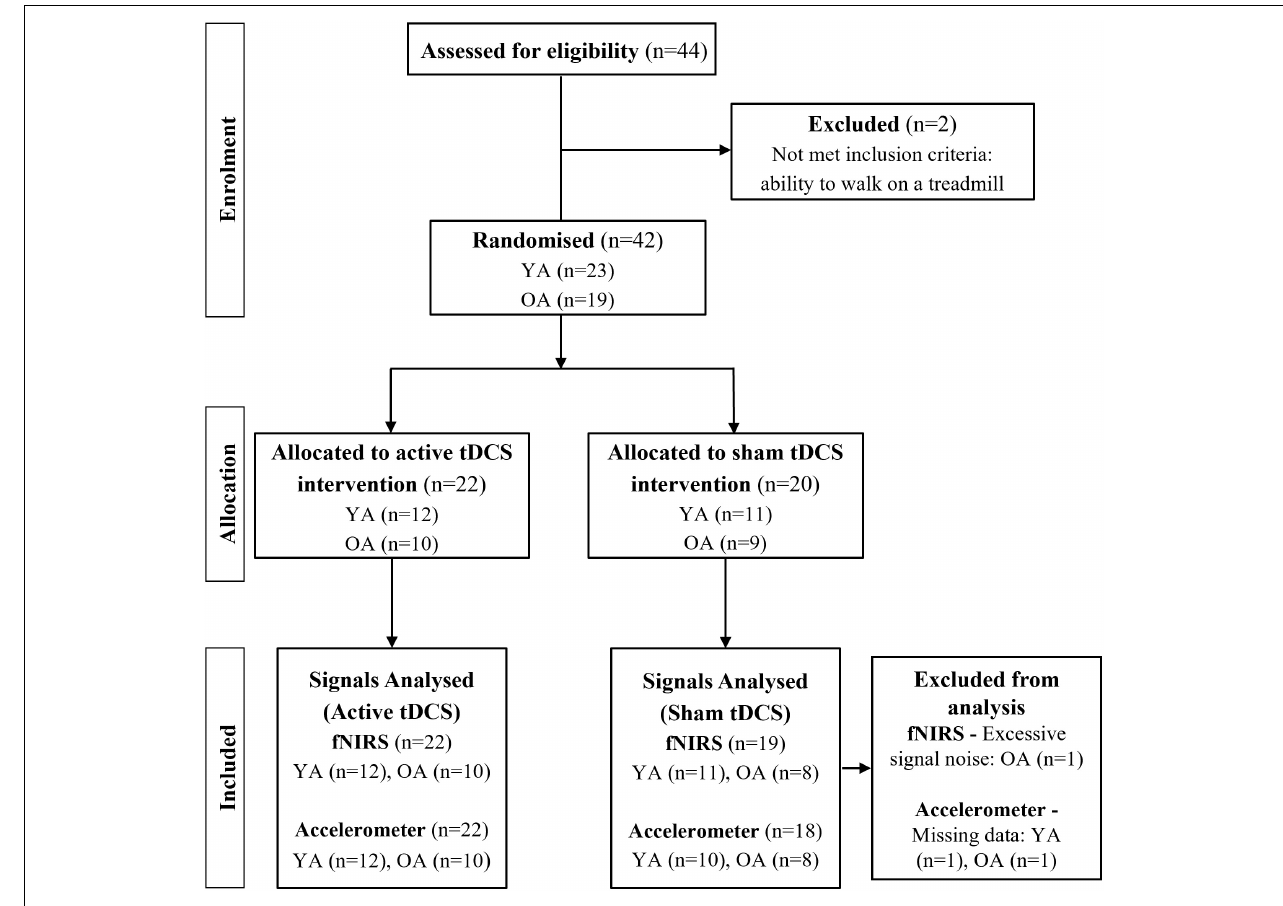
FIGURE 1 | Participant recruitment flowchart. YA: young adults; OA: older adults; tDCS: transcranial direct current stimulation; fNIRS: functional near-infrared